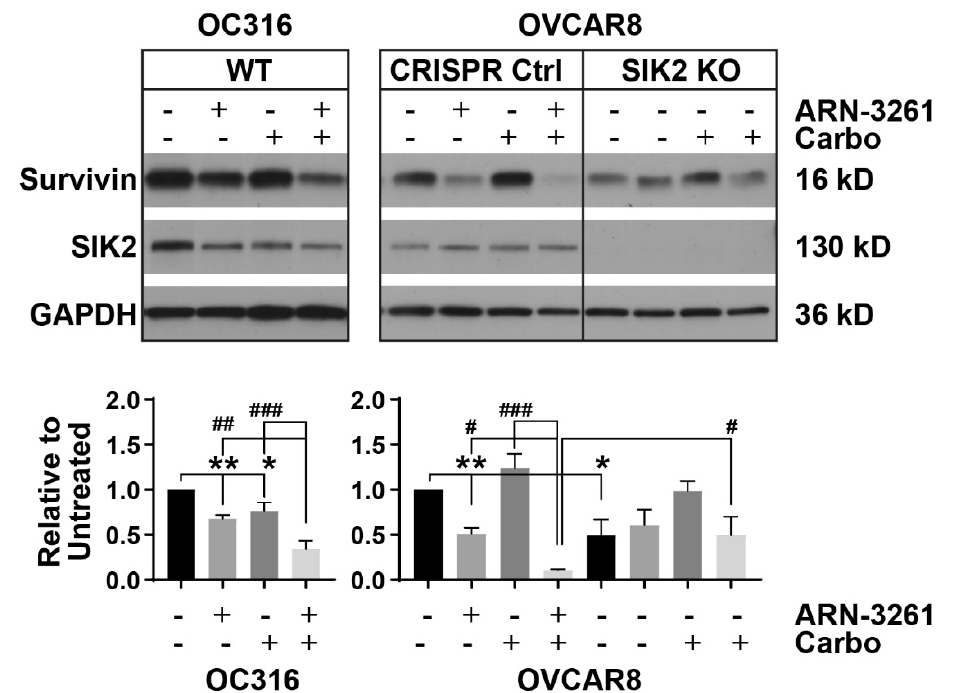
Figure 3. Treatment with ARN-3261 enhances the carboplatin-induced decrease in survivin expression. OC316, OVCAR8, and OVCAR8 SIK2 KO ovarian cancer cells were treated with diluent, ARN-3261 (OC316 3 µ M and OVCAR8 5.0 µ M), carboplatin (OC316 15 µ M and OVCAR8 60 µ M) and the combination for 48 h. Cell lysates were collected and survivin expression was measured by western blot analysis. The experiments were performed three times individually. Densitometry values were determined by Image J shareware (NIH) and normalized to the GAPDH loading control. The values relative to the untreated group were plotted at the bottom. Different treatments were compared by one-way ANOVA analysis. * p < 0.05 and ** p < 0.01 compared to untreated control group; # p < 0.05, ## p < 0.01, and ### p < 0.001 compared to the combination treatment of ARN-3261 and